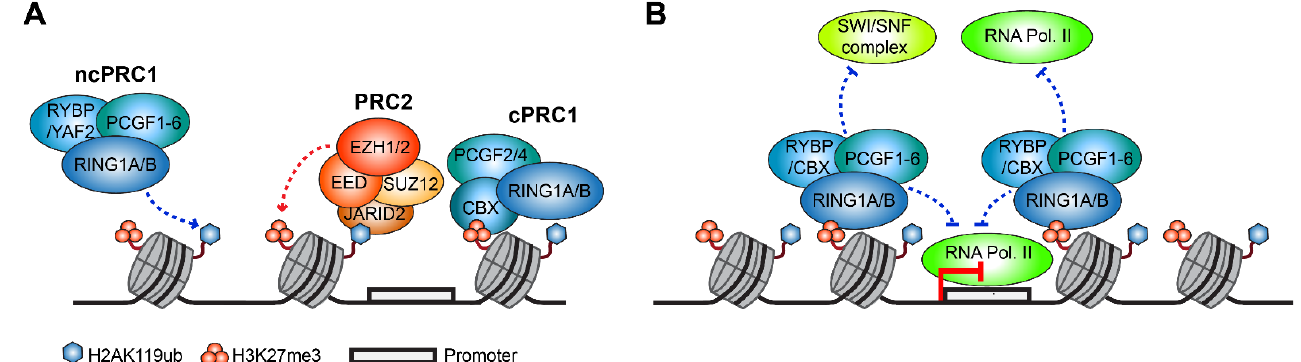
Figure 2. Transcriptional regulation by PRC1-mediated H2AK119ub. ( A ) Polycomb complexes are divided into two principal groups: canonical PRC1 (cPRC1) and non-canonical PRC1 (ncPRC1). ncPRC1 complexes are proficient for H2AK119ub catalysis, and their recruitment is independent of PRC2. The deposition of H2AK119ub promotes the recruitment of PRC2 via its JARID2 subunit. cPRC1 complexes are recruited in a PRC2/H3K27me3-dependent manner via their CBX subunit and possess low H2AK119ub catalytic activity. Instead, cPRC1 complexes synergize with PRC2 to compact chromatin and establish transcriptionally silent Polycomb domains. ( B ) Schematic illustration of H2AK119ub direct role in transcriptional repression. The deposition of H2AK119ub may affect transcription at multiple levels, by limiting accessibility of chromatin remodeling complexes and the transcription initiation machinery, as well as by blocking and interfering with RNA Polymerase II activity.